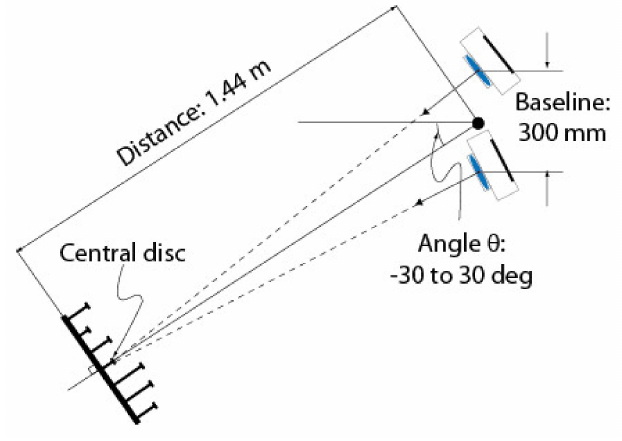
Figure 27. Experimental setup for validating the calibration parameters by 3D reconstruction of a 3D target of known